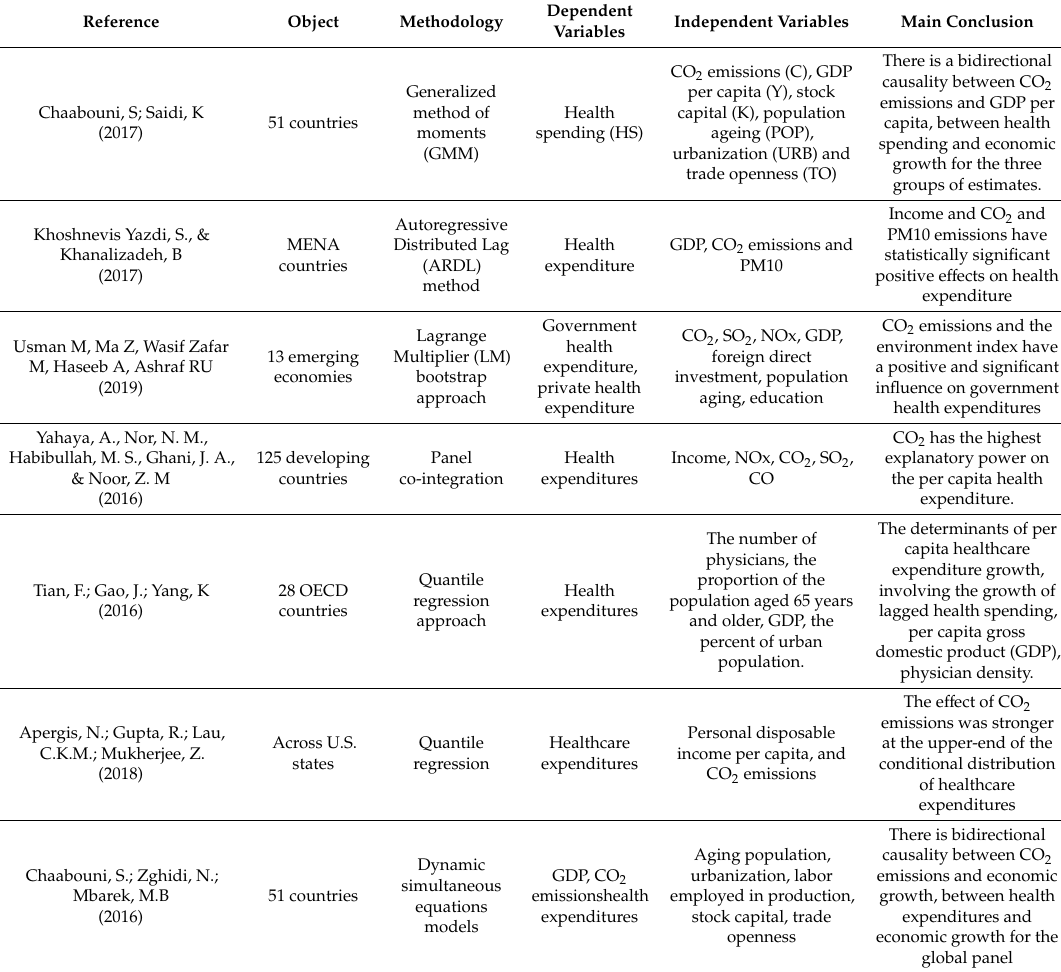
Table 1. A summary of related